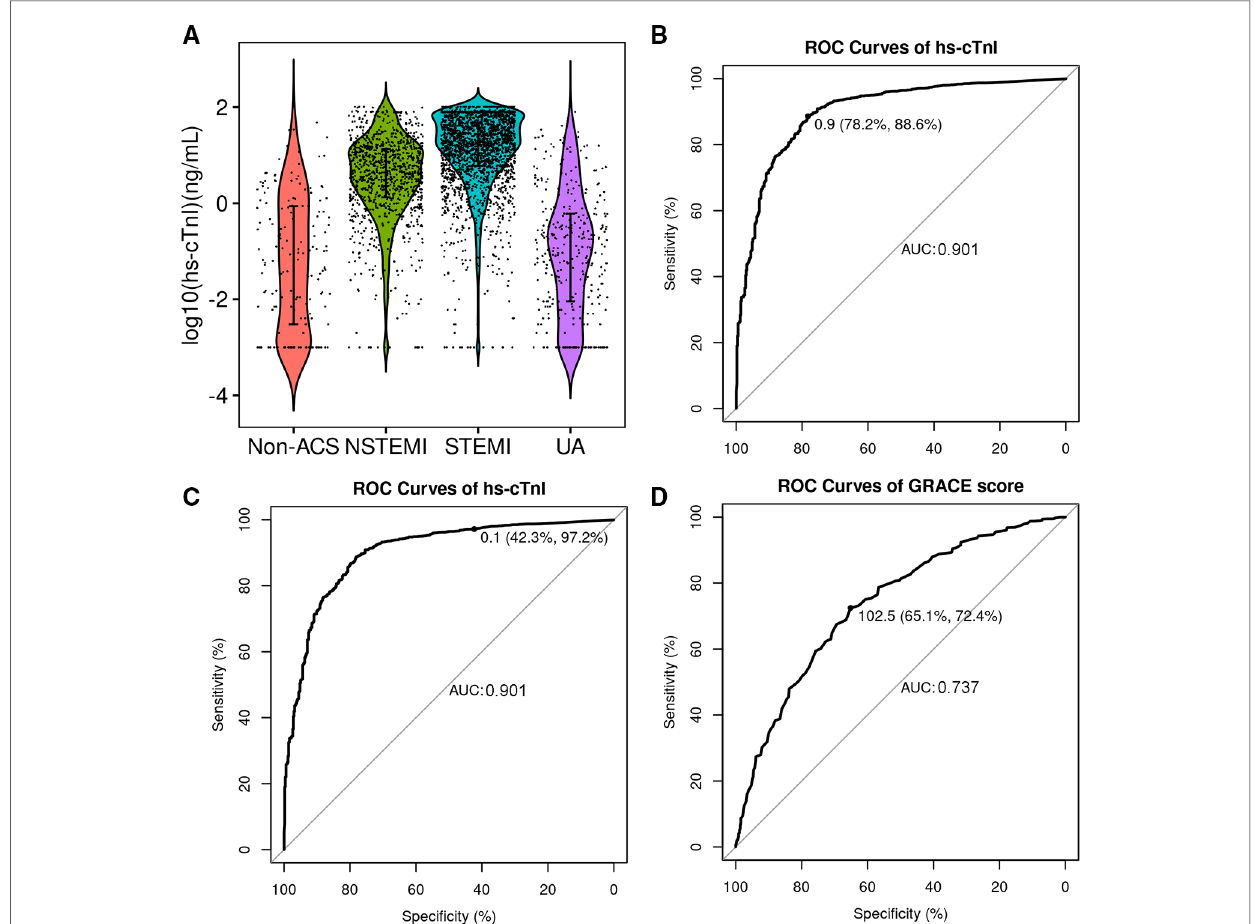
FIGURE 4 The diagnostic performance of high sensitivity (hs)-cTnI and GRACE score. ( A ) Violin plot of hs-cTnI concentration levels in different groups of patients; ( B ) ROC curve of hs-cTnI for AMI diagnosis in all patients with the cut-off value determined by Youden index; ( C ) ROC curve of hs-cTnI for AMI diagnosis in all patients with the cut-off value same as POC cTnI; ( D ) ROC curve of the GRACE score for AMI diagnosis in all patients.